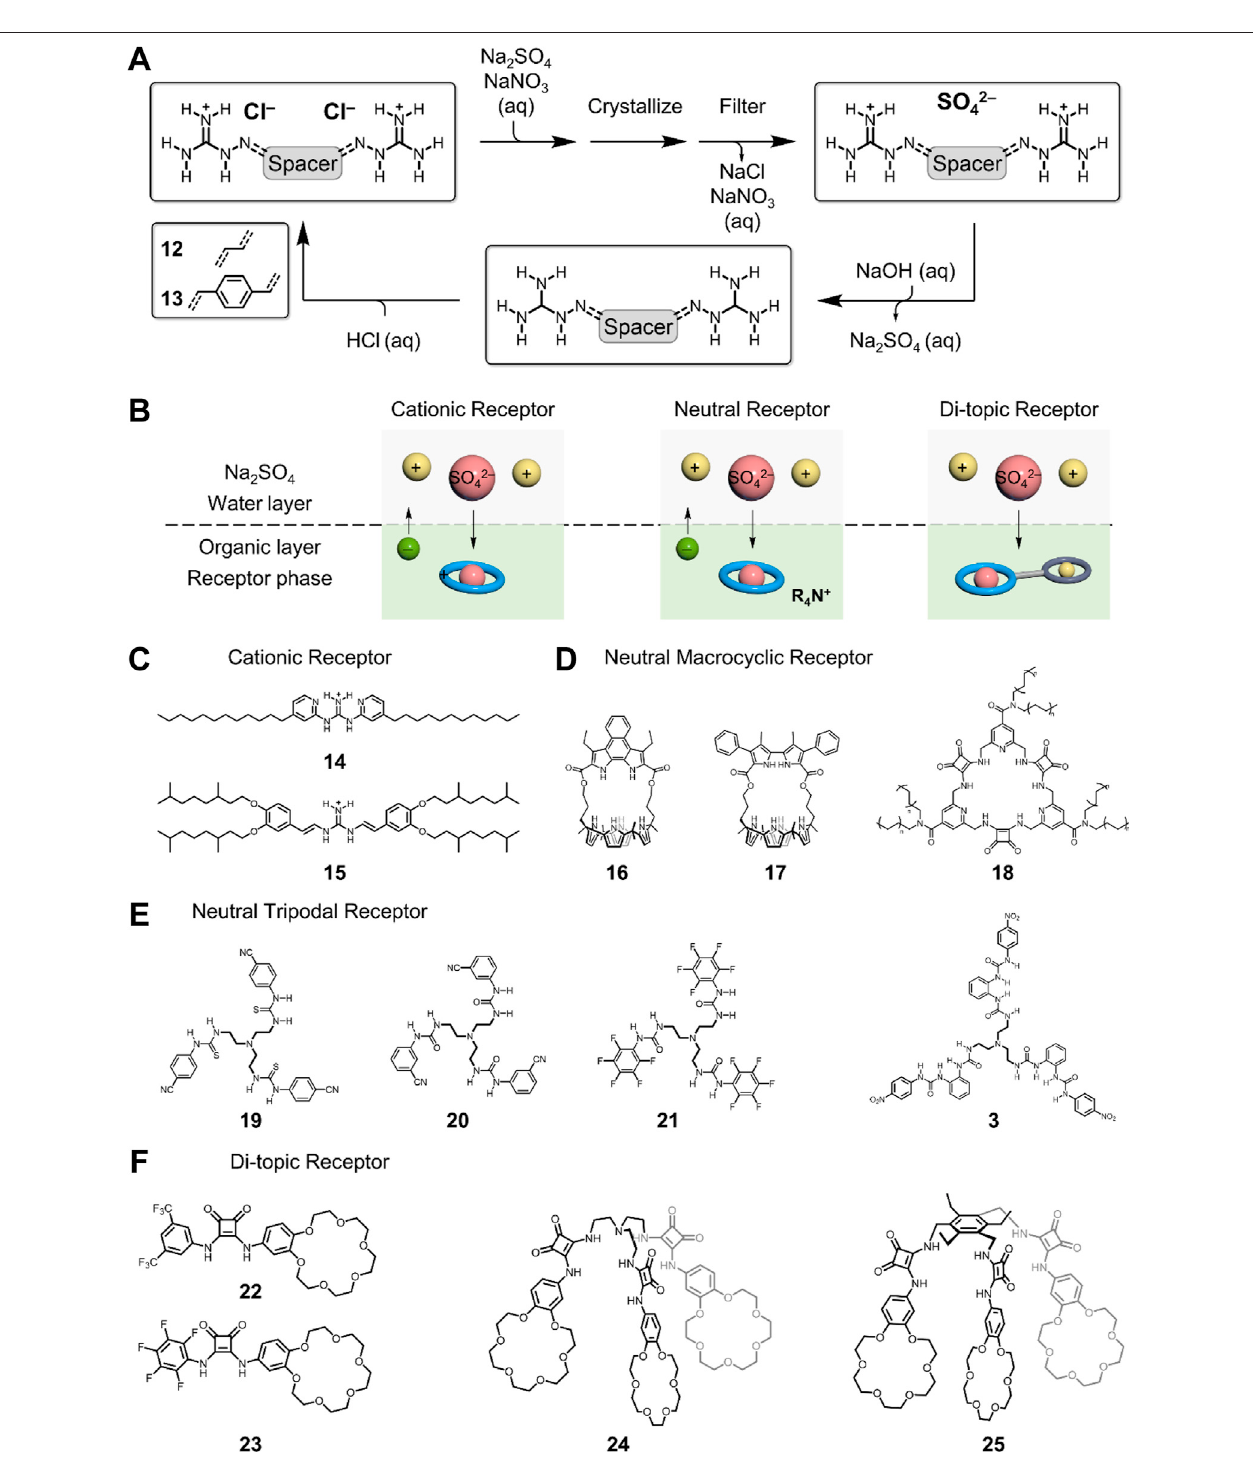
FIGURE 2 | Sulfate separation using (A) crystallization and (B) liquid – liquid extraction. Representative receptors used in liquid – liquid extraction: (C) cationic receptors, (D) macrocyclic receptors, (E) tripodal receptors, and (F) di-topic receptors. It is to be noted that the cyclic shape of the receptor seen in fi gure (2b) does not represent the actual shape for receptors used for sulfate separation.